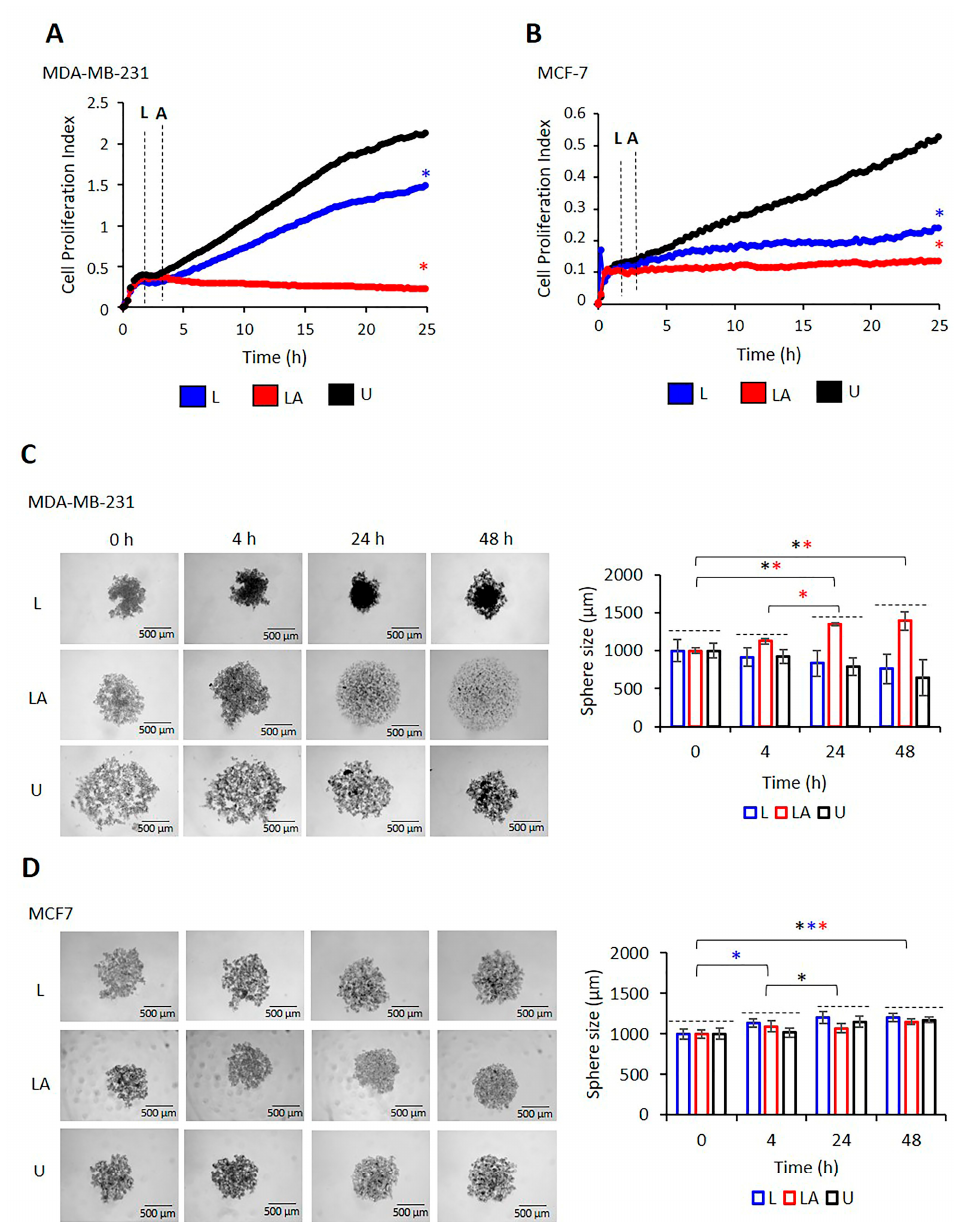
Figure 3. The effect of NLRP3 activation on proliferation and sphere formation of MDA-MB-231 and MCF-7 cells. Cells were incubated with LPS (1 µ g/mL, 3 h) to activate NLRP3, followed by ATP treatment (5 mM ATP; 25 min) to form an inflammasome complex. Images were captured before LPS treatment (time 0), 30 min after ATP treatment (time 4), and 24–48 h after LPS/ATP treatment. The effect of LPS only and LPS/ATP on proliferation kinetics of MDA-MB-231 ( A ) and MCF-7 cells ( B ). Data represent three technical repeats. p value was calculated at the 48th hour using the one-way ANOVA and Tukey test. The sphere formation capacity of MDA-MB-231 ( C ) and MCF-7 cells ( D ) after NLRP3 activation. Images were analyzed using Image J software. p value was calculated using the one-way ANOVA and Tukey test. Data represent five technical repeats. * Comparison of untreated, LPS-only, and LPS-ATP-treated cells at different incubation times. ♦ : Comparison of LPS-only and LPS-ATP-treated cells to untreated cells at the 48 h time point. The mean difference is significant at 0.05 for all analyses (black: untreated cells, blue: LPS-only-treated cells, red: LPS/ATP-treated cells). U: untreated, L: LPS, LA: